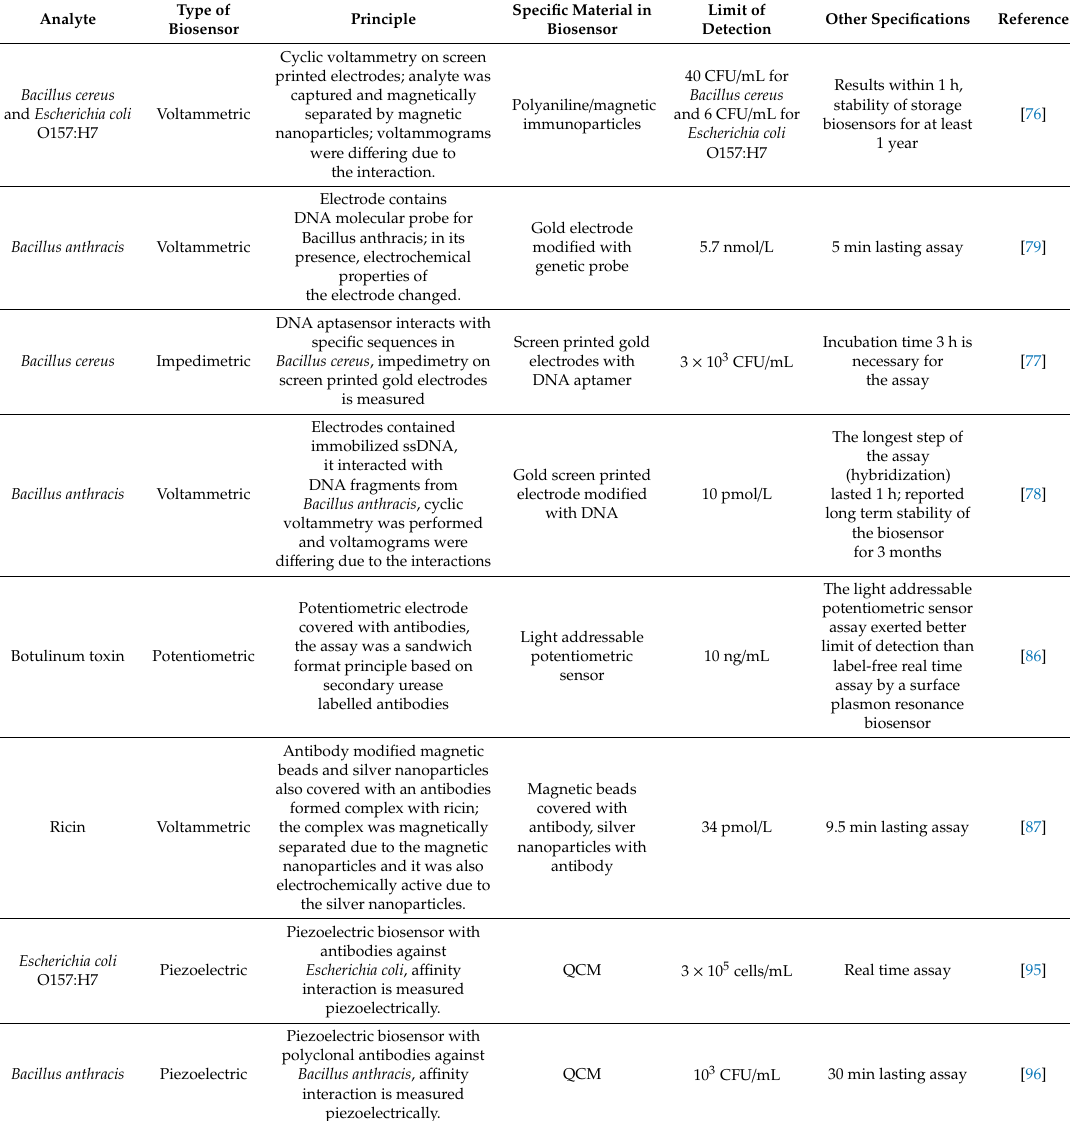
Table 3. Electrochemical and piezoelectric biosensors and bioassays for biological warfare agents’ assay.